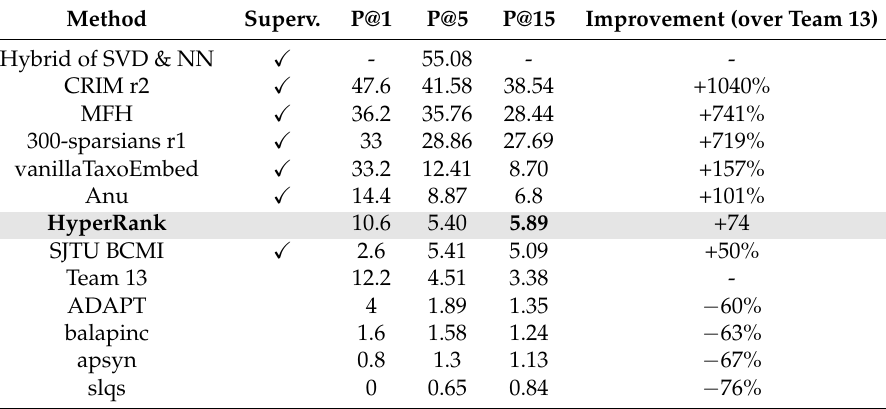
Table 8. Results of evaluation on 2B